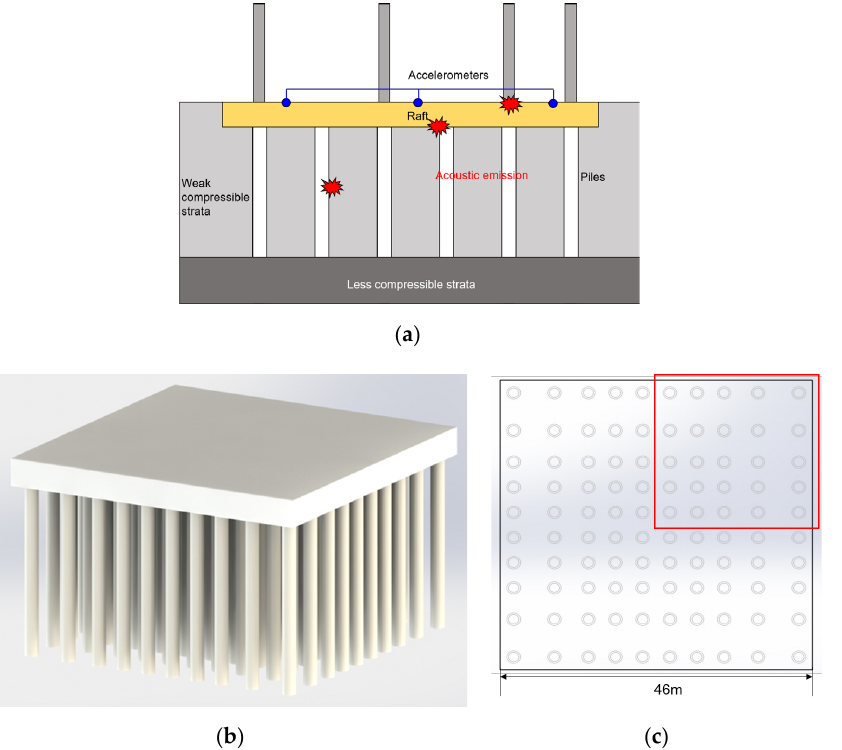
Figure 1. ( a ) Monitoring of structural damage at a piled-raft foundation (PRF), and ( b , c ) schematic diagram of piled-raft foundation (PRF).